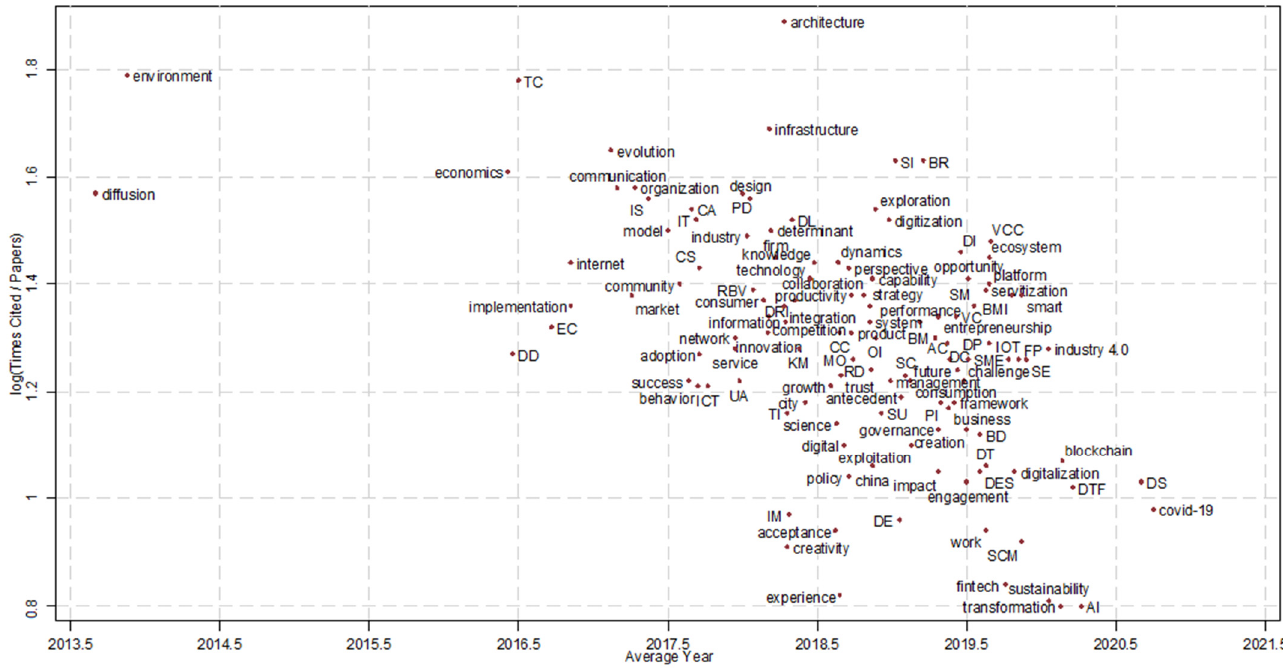
Figure 8. Longitudinal analysis of the most significant keywords.